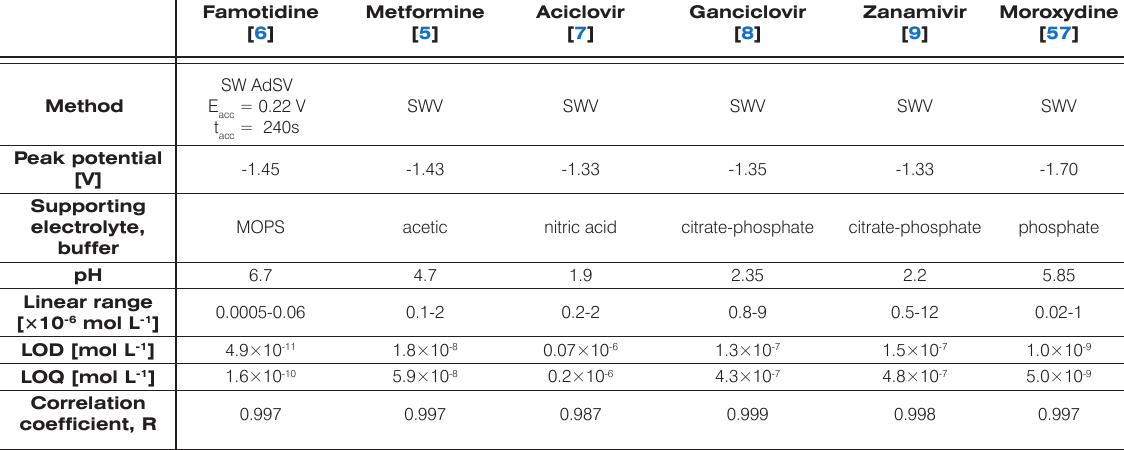
Table 2. Results of voltammetric determination of guanidine compounds - pharmaceuticals at HMDE.